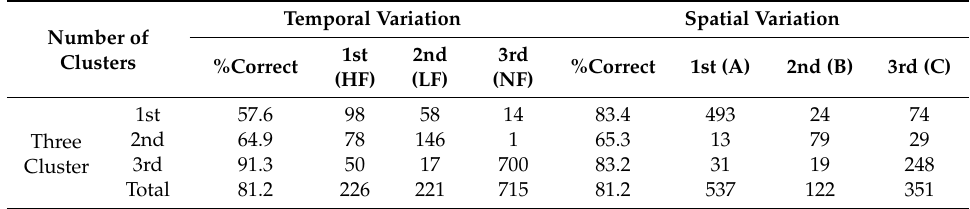
Table 1. Classification matrices for stepwise discriminant analysis of temporal and spatial variations. Number of Clusters